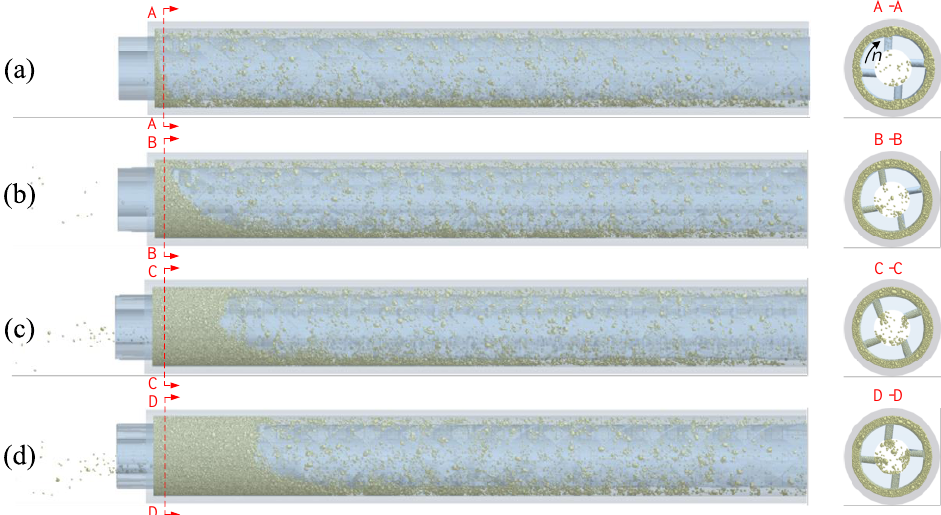
Figure 7. Drilling cutting migration at: ( a ) 0.2 s, ( b ) 0.4 s, ( c ) 0.6 s, and ( d ) 0.8 s.